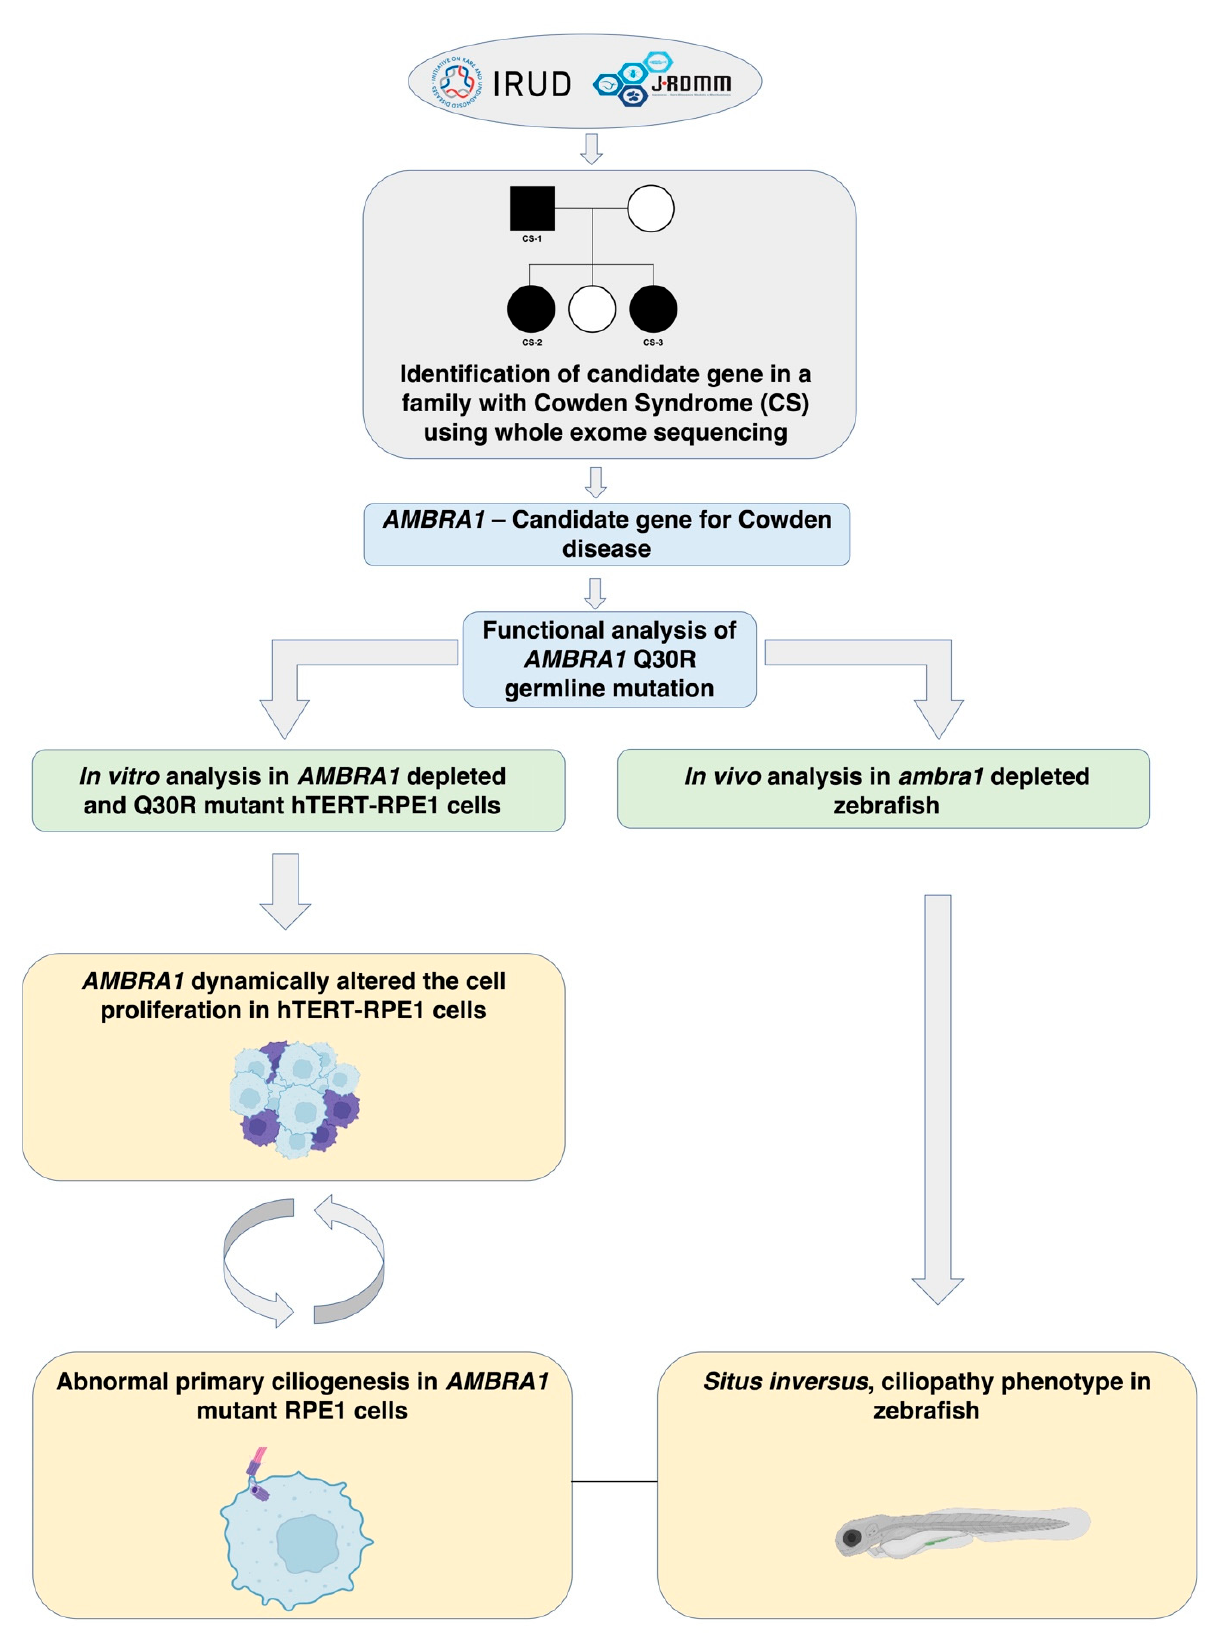
Figure 4. Flowchart for the identification and functional characterization of AMBRA1 as a candidate gene of CS.